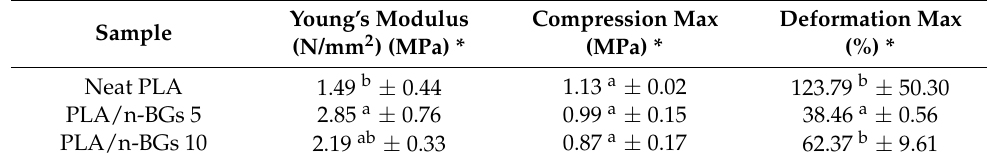
Table 2. Mechanical properties for n-BGs.